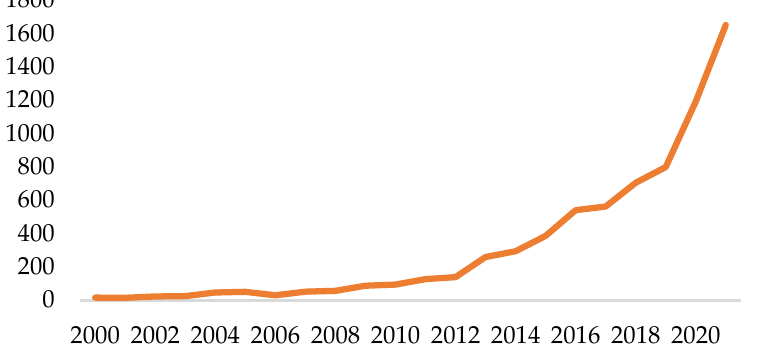
Figure 2. Number of documents per year from 2000 to 2021 based on the ScienceDirect database.